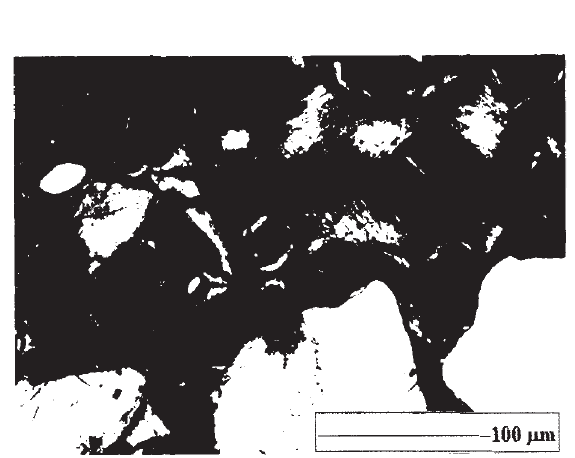
Figura 12. Argilas de iluviação microlaminadas e crescentiformes no horizonte BA do perfil sob 25 anos de cultivo (XPL).